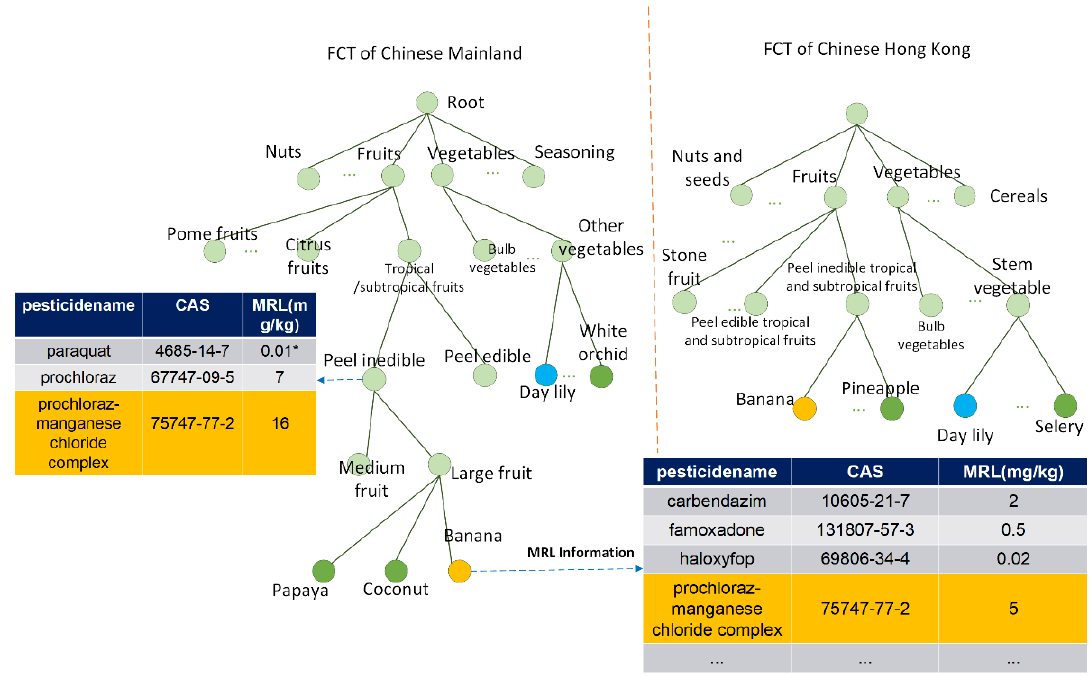
Figure 1. Structure of FCT in Chinese Mainland and Chinese Hong Kong and MRLs of some nodes themselves. The symbol “*” here indicates that the limit is a temporary limit.